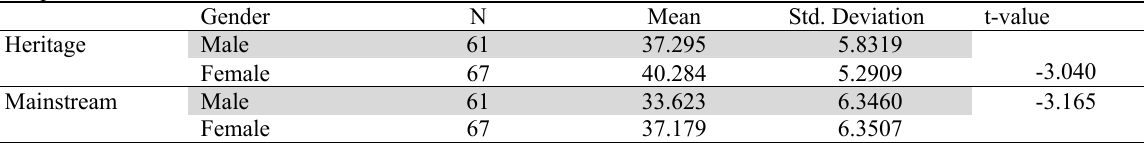
ANOVA based on Age